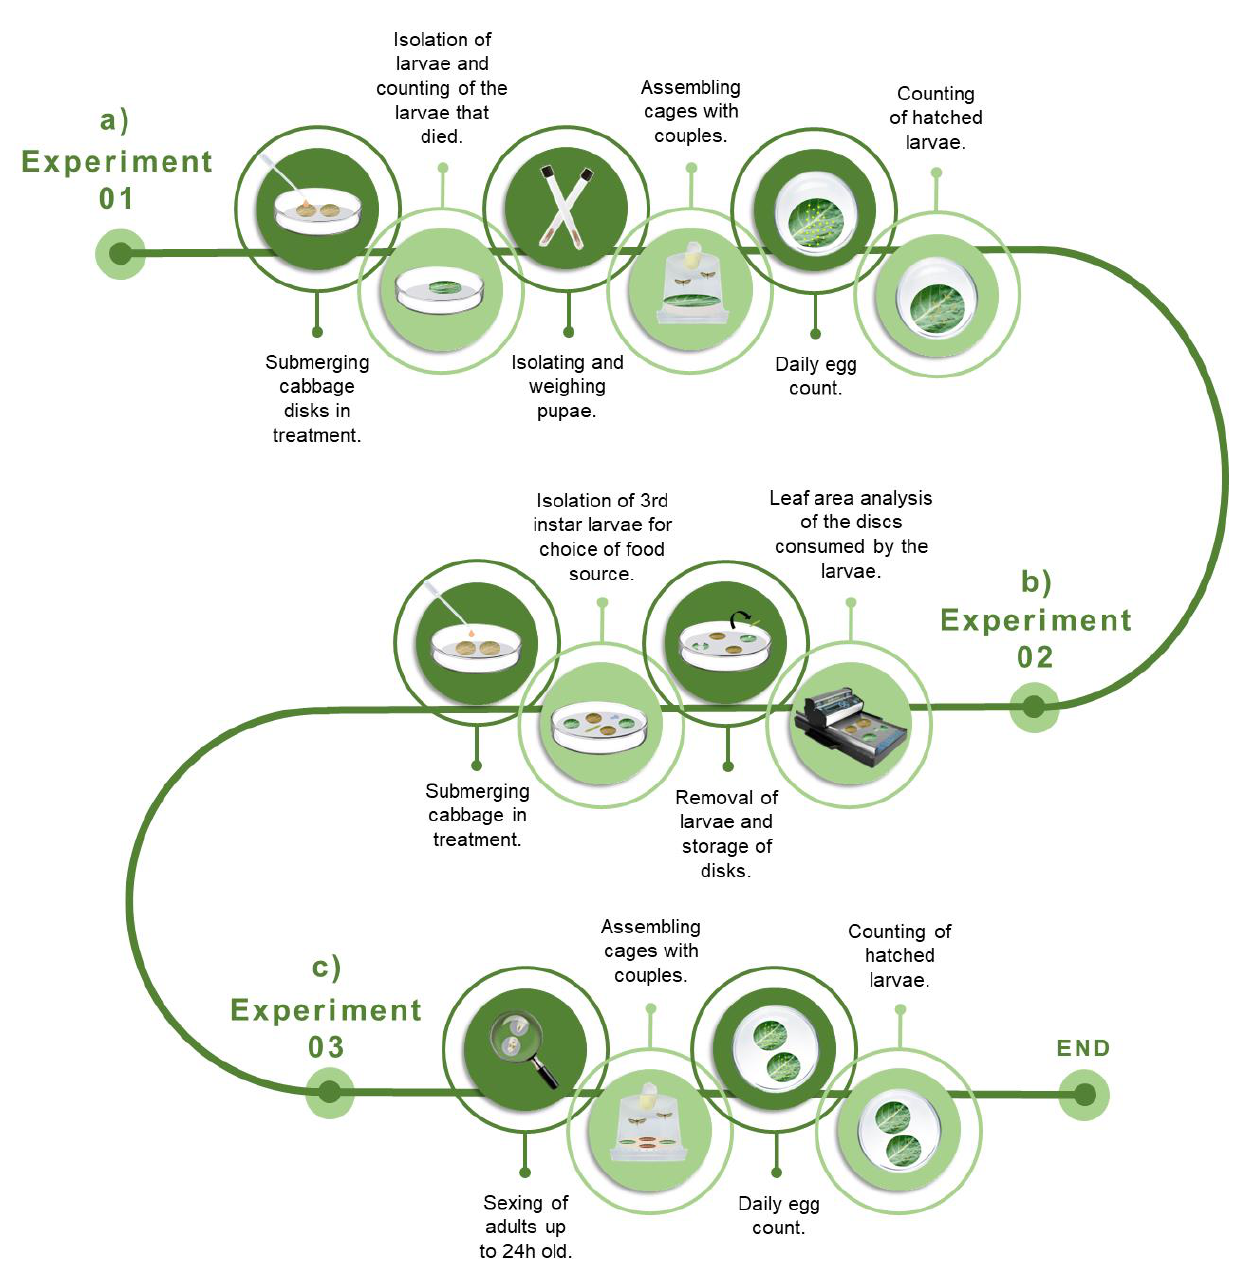
Figure 1. Schematic and chronological representation of the methodology used to evaluate lethal and sublethal effects of M. albicans botanical extracts on P. xylostella : ( a ) Experiment 1: bioactivity of botanical extracts against P. xylostella ; ( b ) Experiment 2: free-choice feeding preference in P. xylostella ; ( c ) Experiment 3: free-choice oviposition preference in P. xylostella . The adults were monitored until they died (female and male